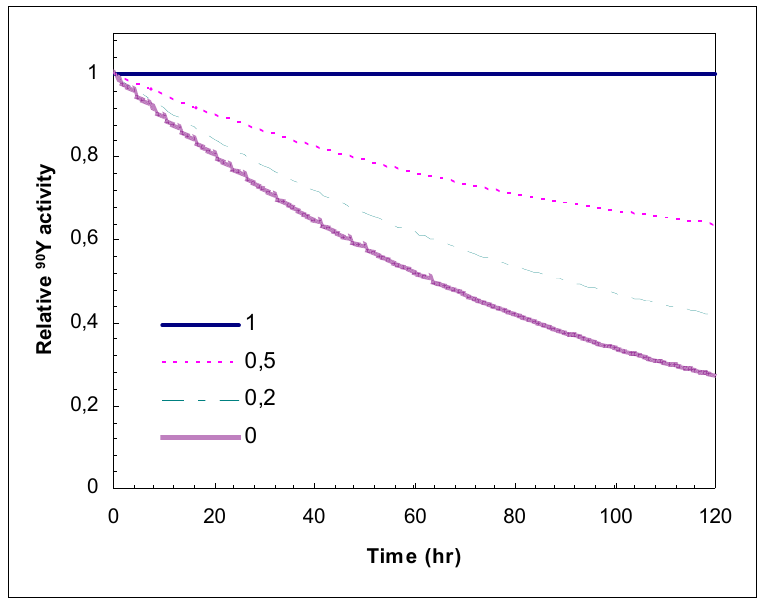
Figure 2. Graph of the relative 90 Y activity as a function of the initial activity ratio ( four ratios plotted above are 1, 0.5, 0.2, and 0. The top line, corresponding to an initial activity ratio of unity, results from a sample initially existing in secular equilibrium. The remaining curves asymptotically approach secular equilibrium. The bottom curve, representing the case where no 90 Sr is present, asymptotically approaches zero and is simply the 90 Y decay curve with a 64.1 hour half-life. Not shown here are curves that would increase if the initial 90 Sr concentration exceeded that of 90